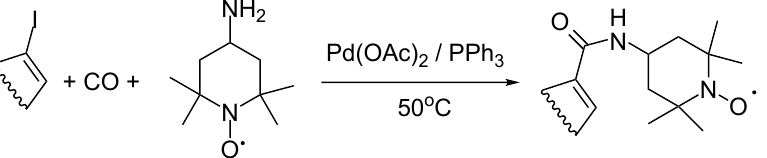
Figure 7. Pd-catalyzed aminocarbonylation of iodoalkenes with 4-amino-TEMPO.